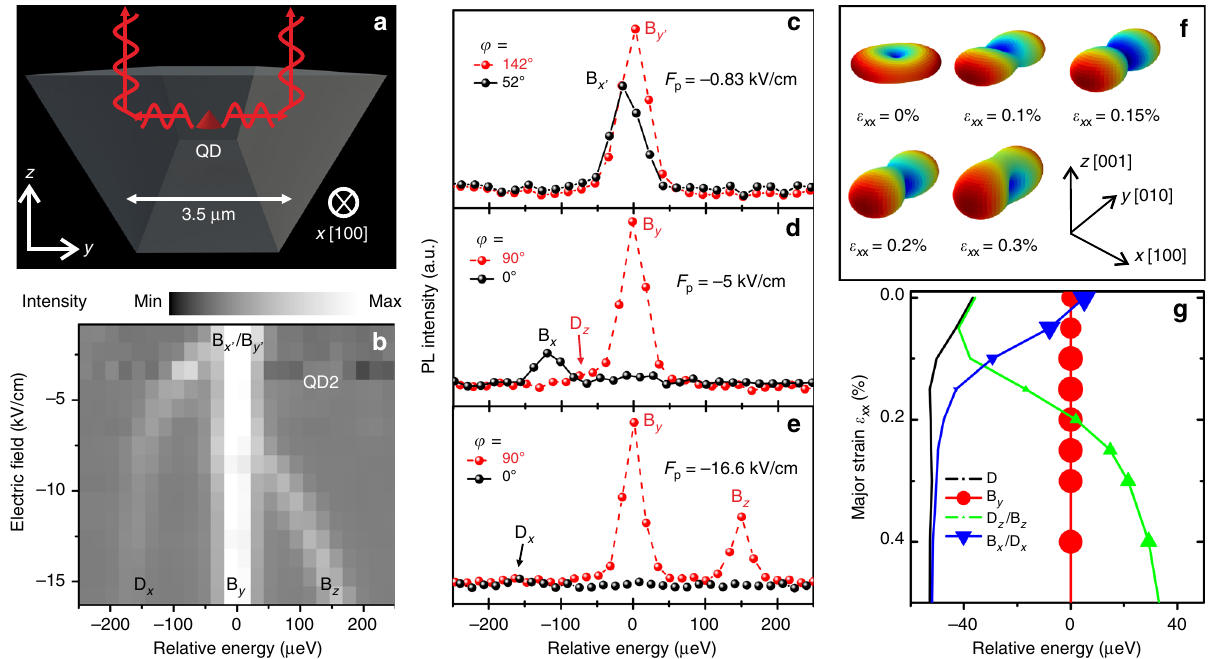
Fig. 4 Evolution of the fi ne structure of a neutral exciton con fi ned in a GaAs QD for increasing uniaxial stress and comparison with theory. a Sketch of the cross-section ( y – z plane) of the stripe-like membrane used to project the vertically polarized component B z into the collection optics (see Fig. 2b). The pulling ( x ) direction is orthogonal to the y – z plane. From the geometry, we expect such light to appear as y- polarized. b PL spectra of the neutral exciton (X) emission of a QD as a function of electric fi eld applied to the piezoelectric actuator. Spectra are shifted horizontally using the line labeled as B y ′ or B y as reference. c – e Representative linearly polarized PL spectra of the X emission in the same QD for different values of the fi eld F p applied to the actuator (uniaxial stress). In c , we see the usual fi ne-structure splitting (FSS) of a HH z exciton, characterized by two orthogonally polarized lines. The observed polarization anisotropy, relatively large FSS (14 µ eV), and random orientation of the polarization directions are mostly ascribed to HH z – LH z mixing induced by QD anisotropy and process-induced prestress. The applied uniaxial stress aligns the transition dipoles along and perpendicular to the stress axis, as shown in d and e . z- polarized emission appears fi rst as a shoulder on the low energy side of the B y line (marked as D z in d ). The emission of a HH x exciton is shown in e . f Polar-coordinate representation of the excitonic transition dipole calculated by the EPM + CI. g Relative transitions energies of the four excitonic components under uniaxial stress (compressive, top and tensile, bottom) computed by EPM + CI. The symbol size is proportional to the oscillator strength of the